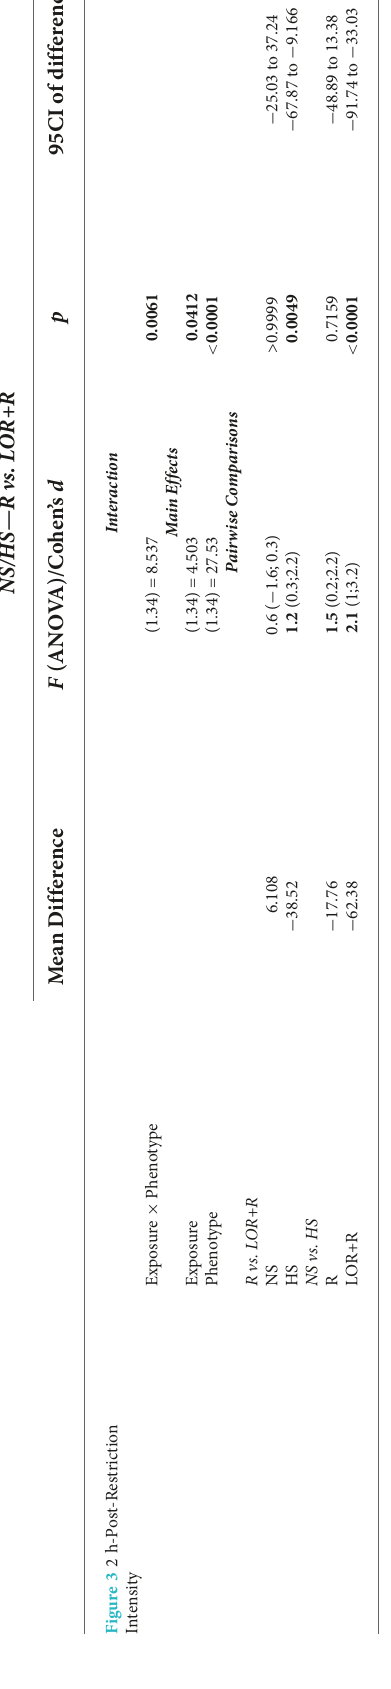
during which behavioral restriction was applied, were compared. For this analysis, data from all three nights were pooled. In the behavior of NS animals ( Figure 4A ; Table 4 ), no significant two-way exposure-time interaction was shown. Rather, time impacted the result in a significant manner ( p = 0.0169). Here, a significant increase in the stereotypical intensity shown by NS animals exposed to LOR was shown ( p = 0.0083). For HS animals ( Figure 4B ; Table 4 ), no interaction effect, nor any main effects of exposure and time, were shown.